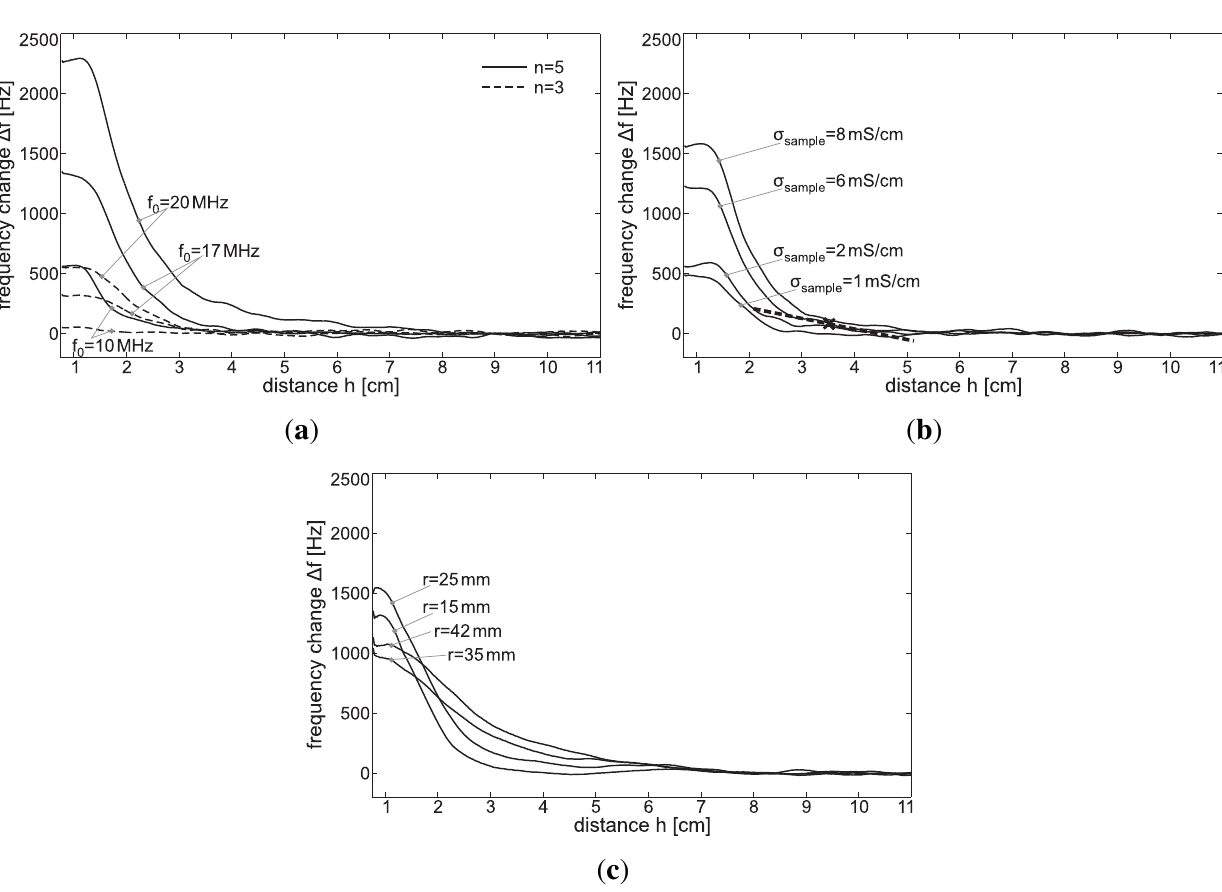
Figure 6. Results of the examination of sensor response and measuring depth. The signal output, ∆ f , is presented in relation to the signal-to-object distance (height h ). f is the tuned 0 base frequency of the sensor, σ the conductivity of the sample object, r the radius of the sample sensor coil and n the number of windings. ( a ) f is varied, σ = 8 ms/cm, r = 30 mm; 0 sample ( b ) σ is varied, f = 17 Mhz, n = 5, r = 30 mm; ( c ) r is varied, σ = 6 ms/cm, sample 0 sample f = 20 Mhz, n = 5. 0